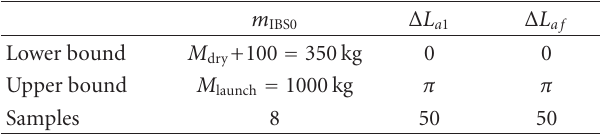
Table 1: Bounds and number of samples for the de-orbit parame- ters. m IBS0 Δ L a